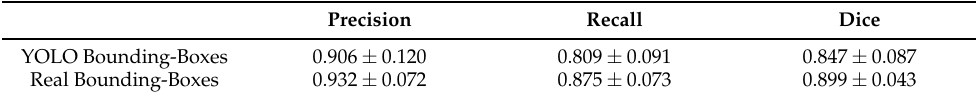
Table 5. Comparison of segmentation performance when using the real bounding-boxes and predicted bounding-boxes for the FLAIR without post-processing. Results present the mean ± standard deviation.